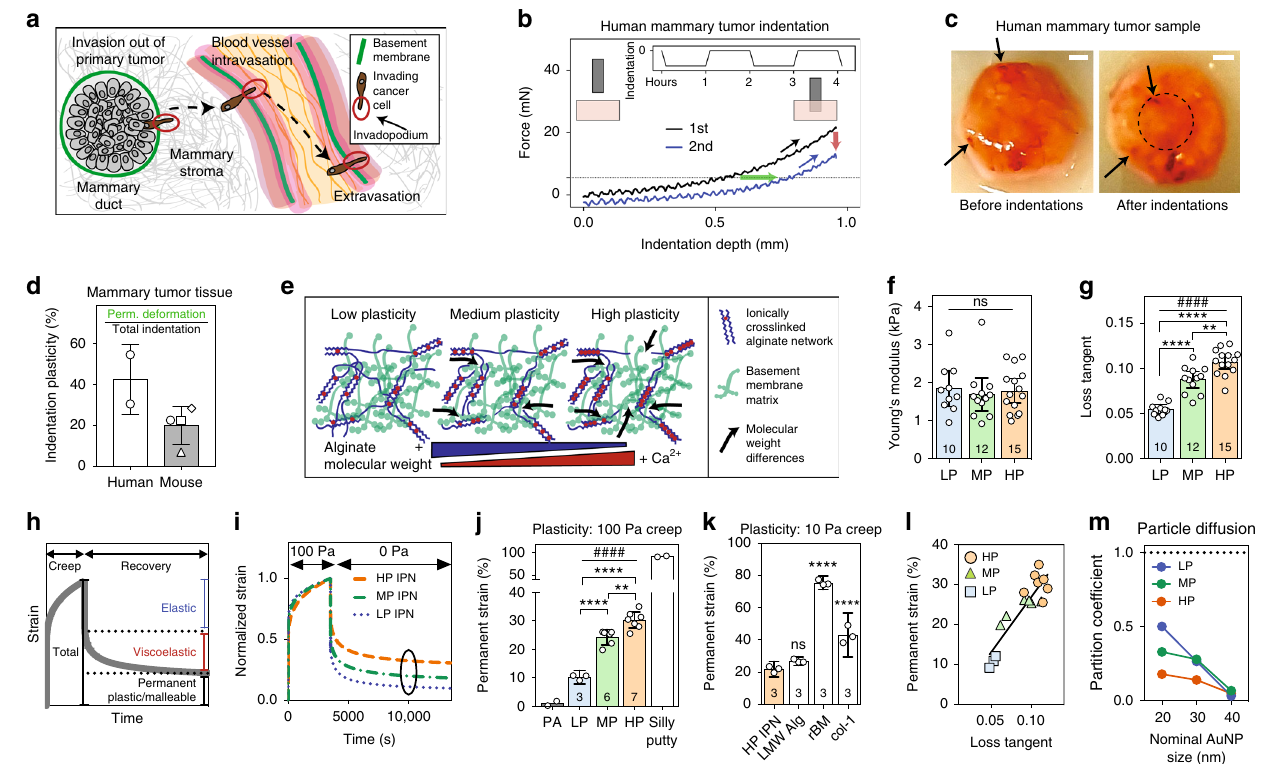
Fig. 1 Mechanical plasticity of interpenetrating networks of alginate and reconstituted basement membrane matrix (IPNs) can be independently tuned. a Schematic depicting invasion of basement membranes (green) during invasion and metastasis. b Schematic depicting the indentation tests performed on human mammary tumor tissue, and the corresponding force vs. indentation depth curves (green arrow — permanently retained indentation; red arrow — drop in peak force during second indentation; dotted line — 25% of initial peak force). Subplot shows indentation test pro fi le. c Before and after images of an indented mammary tumor sample. Indentation region outlined by dotted circle, and discolored tissue regions indicated by black arrows. Scale bar is 1 mm. d Indentation plasticity measurements of human tumor (two specimens from a tumor sample) and mouse tumor specimens (one sample each from four separate mice). e Schematic of approach to tuning matrix plasticity in IPNs of alginate (blue) and reconstituted basement membrane (rBM) matrix (green). f , g Young ’ s moduli ( f ) and loss tangent ( g ) of the different IPN formulations. The differences in loss tangent indicated are signi fi cantly different (** P < 0.01, **** P < 0.0001, ANOVA; ns not signi fi cant), as is the increasing loss tangent across this series of IPNs ( #### P < 0.0001, Spearman ’ s rank correlation). h Schematic depicting the elastic, viscoelastic, and plastic (permanent) portions of a material response in a creep and recovery test. i Representative creep and recovery tests of IPNs. j Permanent strain of IPNs, polyacrylamide gels (PA), and silly putty from creep and recovery tests. Statistically signi fi